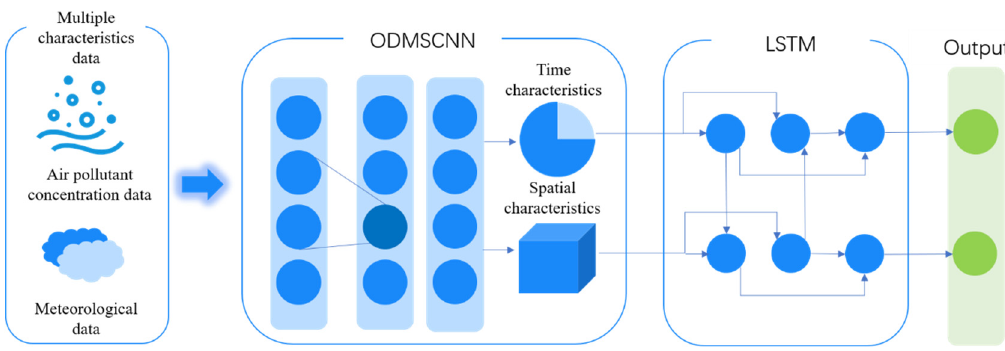
Figure 5. ODMSCNN-LSTM model structure.